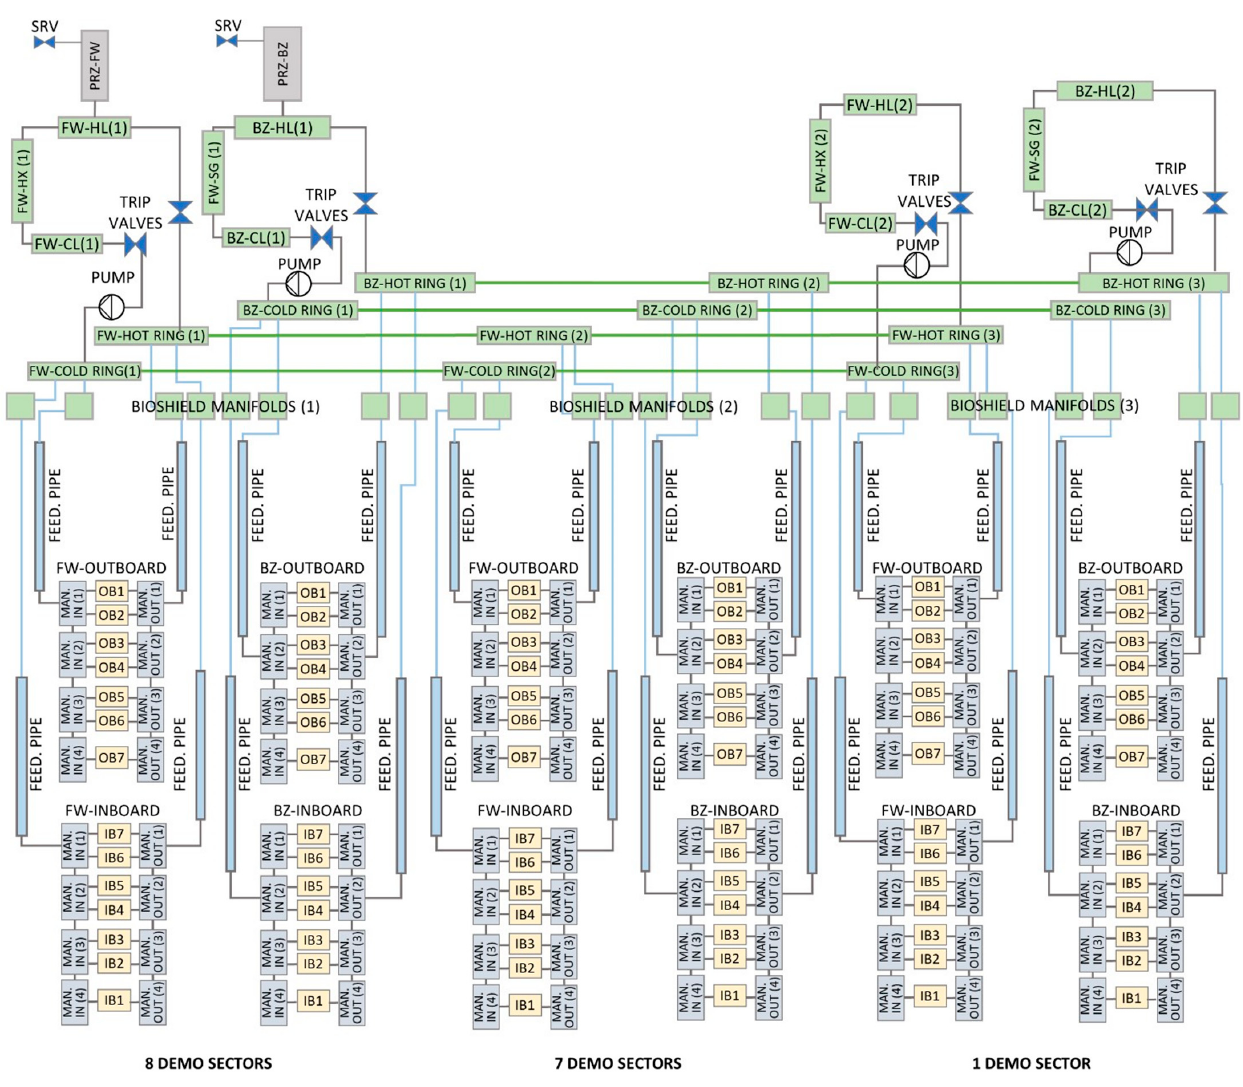
Figure 4. MELCOR PHTS nodalization scheme.